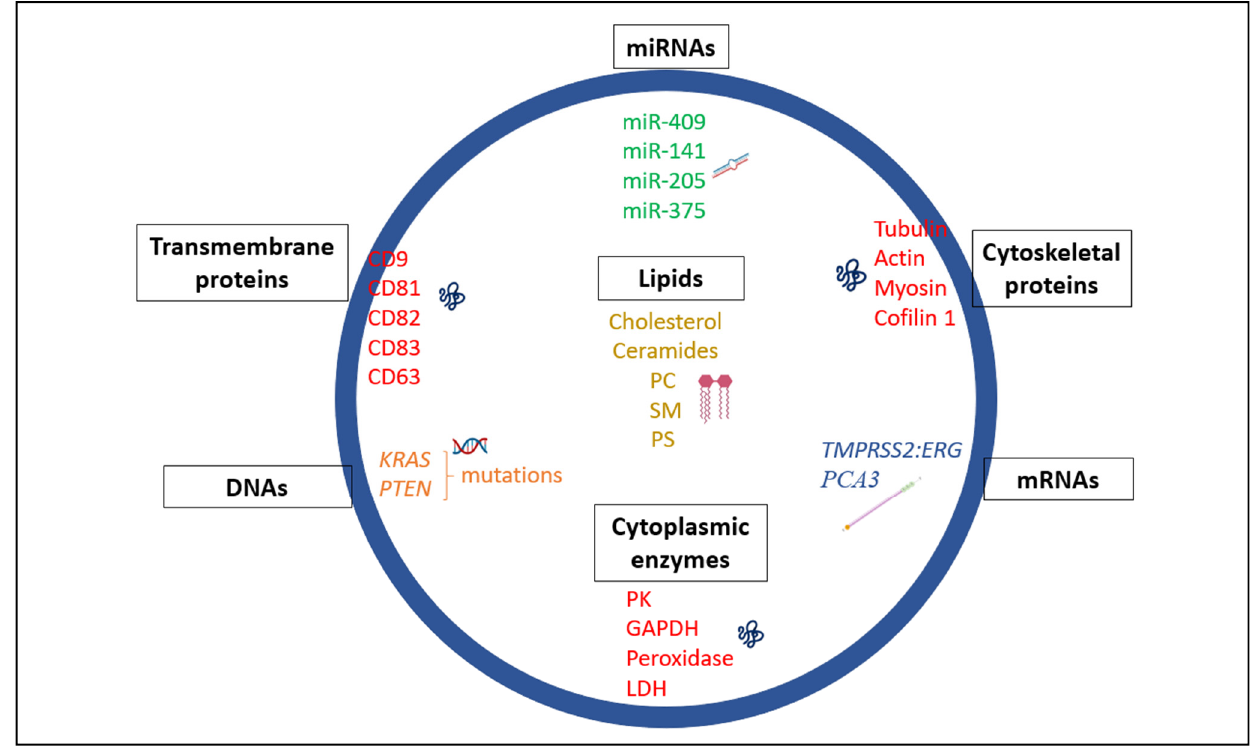
Figure 1. Schematic of exosome heterogeneity. Exosomes typically serve as vehicles in shuttling a cargoes of proteins, miRNAs, mRNAs, DNAs, and lipids across cells. Phosphatidylcholine is abbreviated as PC, sphingomyelin as SM, phosphatidylserine as PS, Pyruvate Kinase as PK, lactate dehydrogenase as LDH, and glyceraldehyde 3-phosphate dehydrogenase as GAPDH.